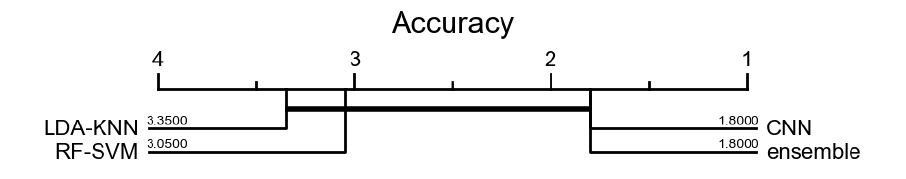
Figure 12. Statistical comparison of the 4 models over the physical activities classes. Average ranks of examined models are presented. A thick horizontal line shows a group of classifiers that are not significantly different in terms of